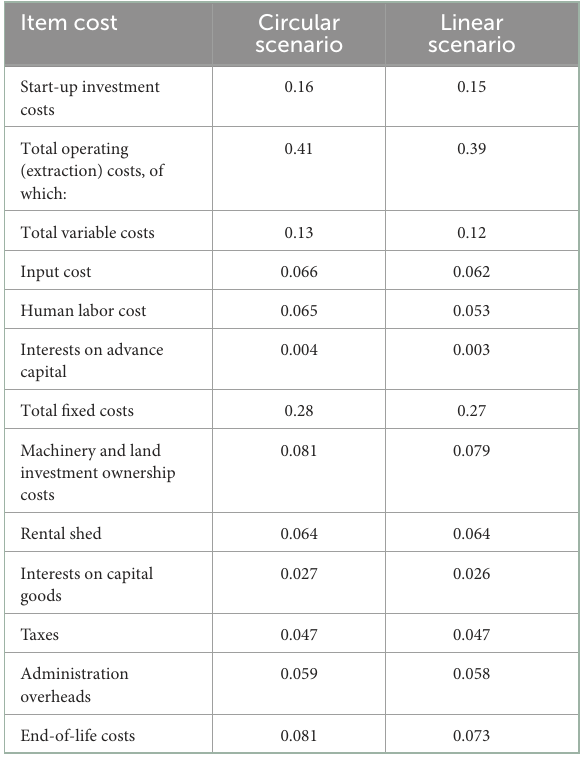
TABLE 4 Olive production costs of the circular vs. linear scenario per life cycle stages ( e ha − 1 year − 1 ). Life cycle stages Circular scenario